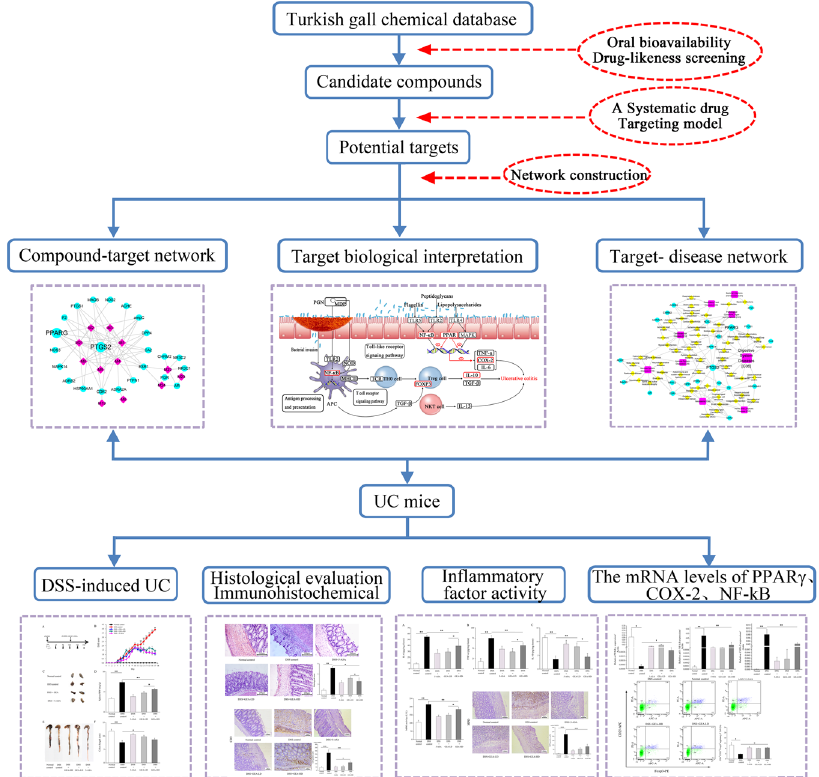
Figure 1. Systems pharmacology approach